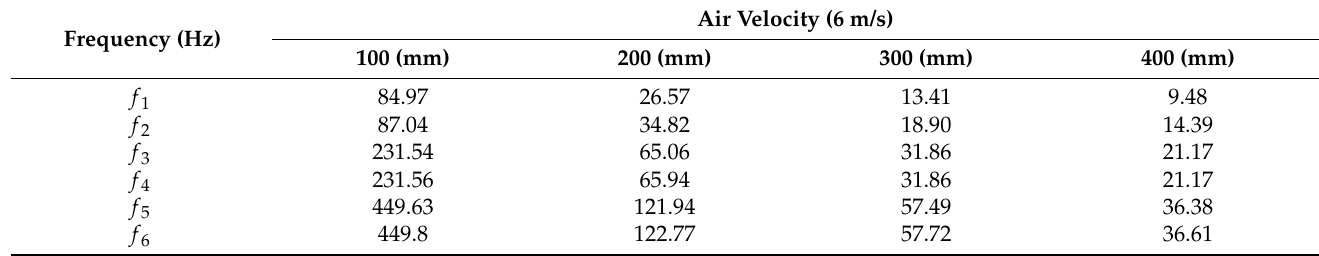
Table 7. The first 6-order natural frequencies with different fiber lengths at air velocity 6